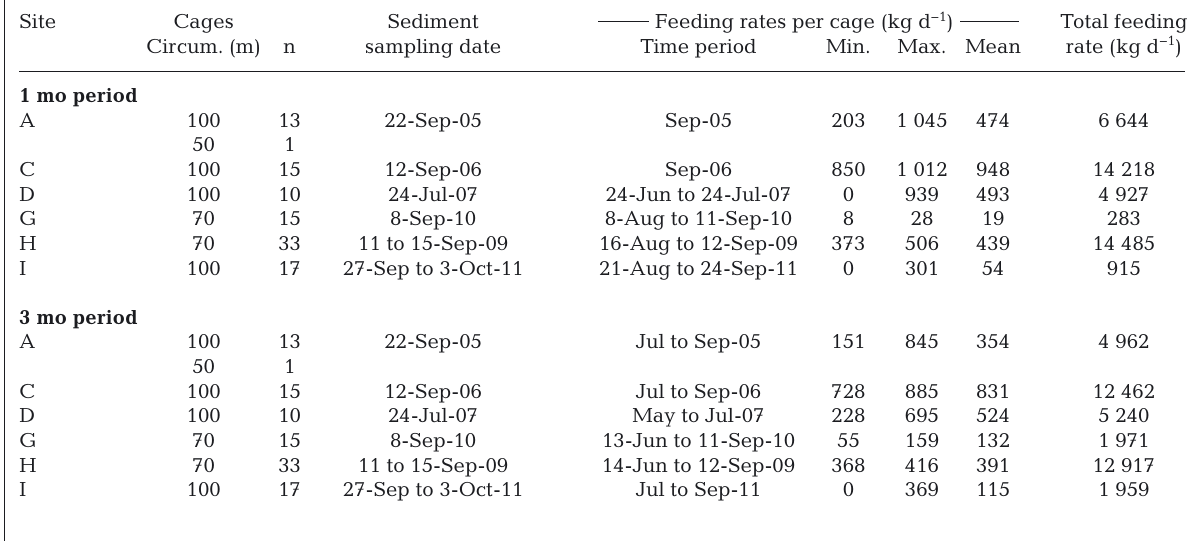
Table 4. Feeding rates during 1 mo and 3 mo periods used in DEPOMOD runs at 6 salmon farms. 1 mo periods: feeding rate periods included the sediment sampling dates, except at Site I which completed harvesting 5 d prior to sampling. 3 mo